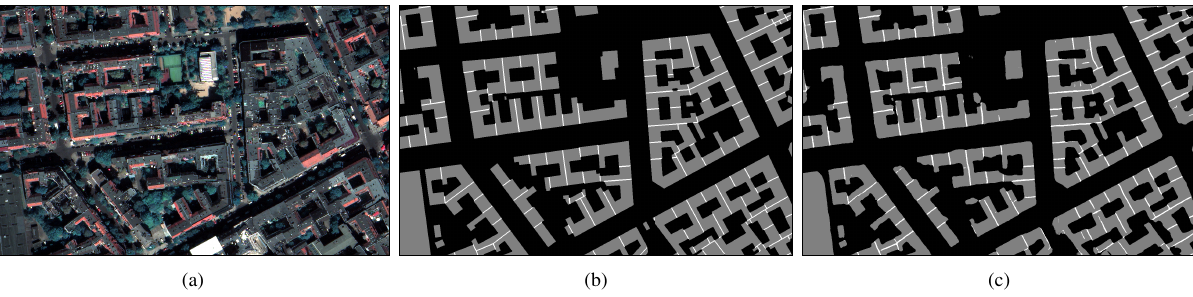
Figure 7. Test area sample showing (a) RGB, (b) ground truth and (c) raw prediction output from SkipFuse-U-DenseNet121 with RGB and